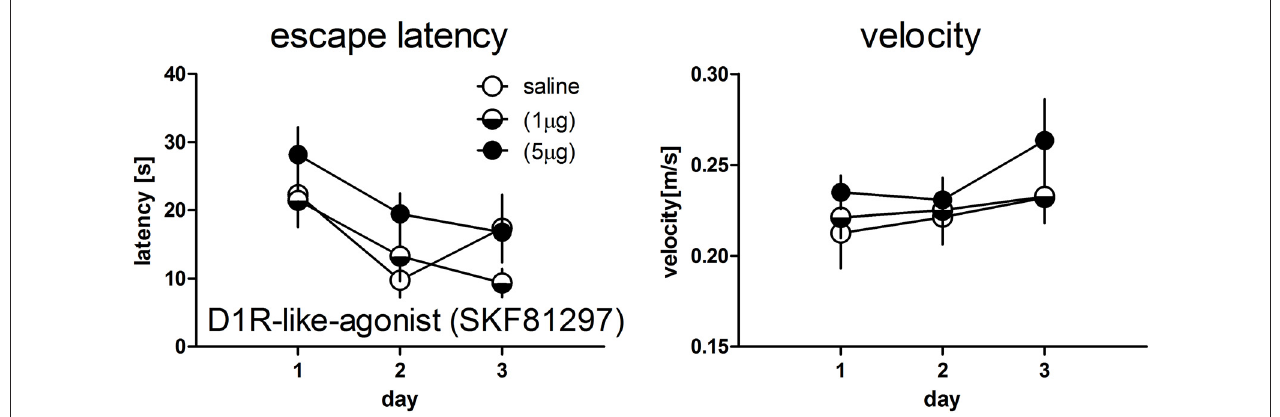
FIGURE 2 | Escape latencies (left panel) and mean velocity (right panel) during test trials in the water maze working memory task in rats treated with saline ( n = 9) or the D1R-like-agonist at a dose of 1 µ g ( n = 10) or 5 µ g ( n = 8). No significant differences between groups could be detected. Given are the mean values and